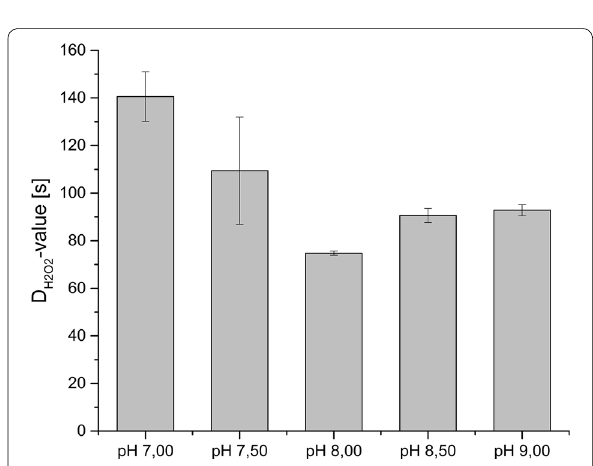
Fig. 4 Resulting D H2O2 -values of the different static pH cultivations, D H2O2 -values in seconds